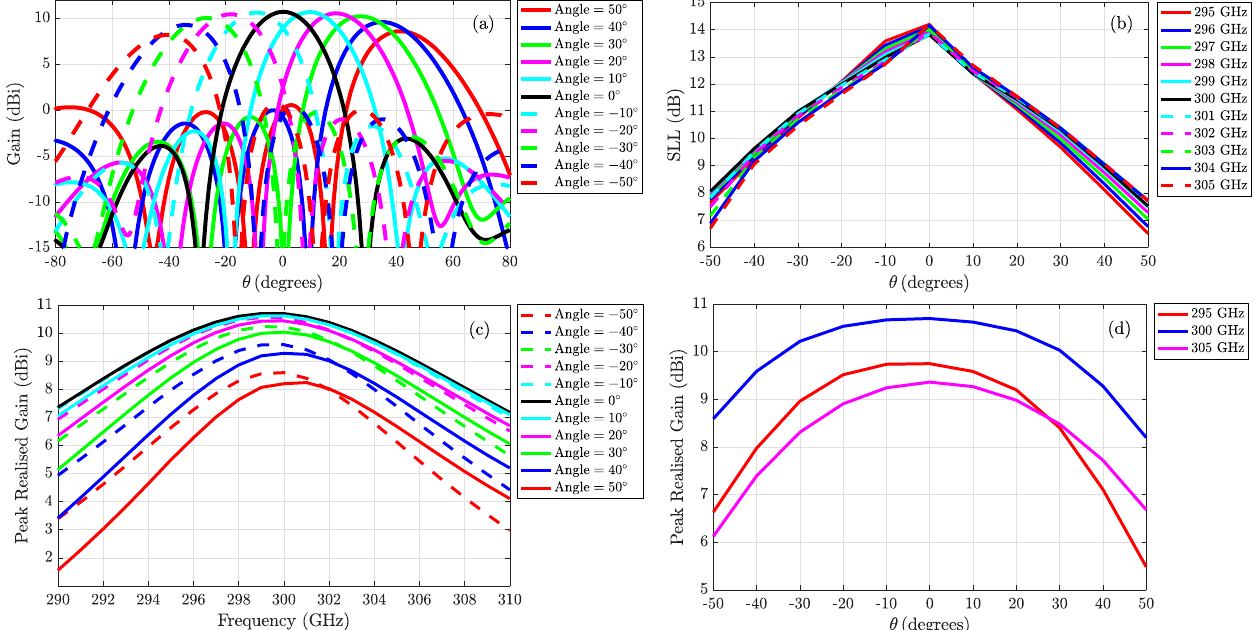
Figure 6. ( a ) Steering pattern for 1 × 4 array, ( b ) SLL of the array, ( c ) Peak realised gain vs. frequency for varying steering angles, ( d ) Peak realised gain vs. steering angle for different frequencies.